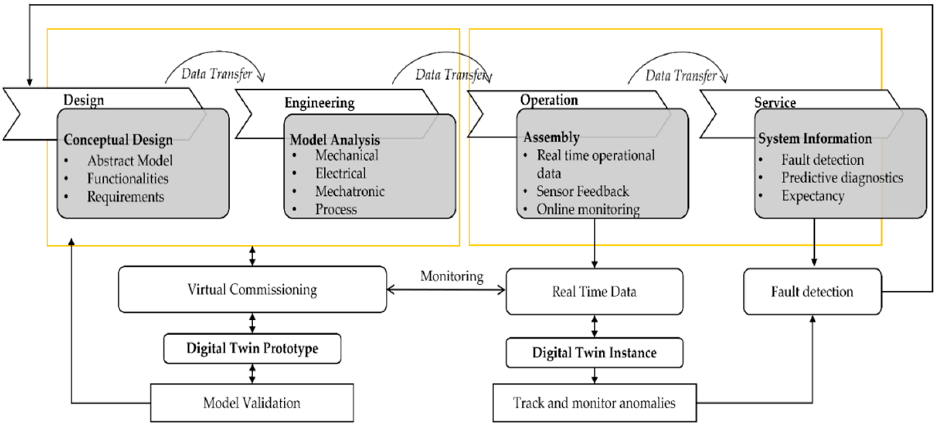
Figure 5. Overview of simulation-based DT. The data collected at each stage of the product development are used to create a digital instance of the physical object. The digital object is developed in parallel with the physical object.